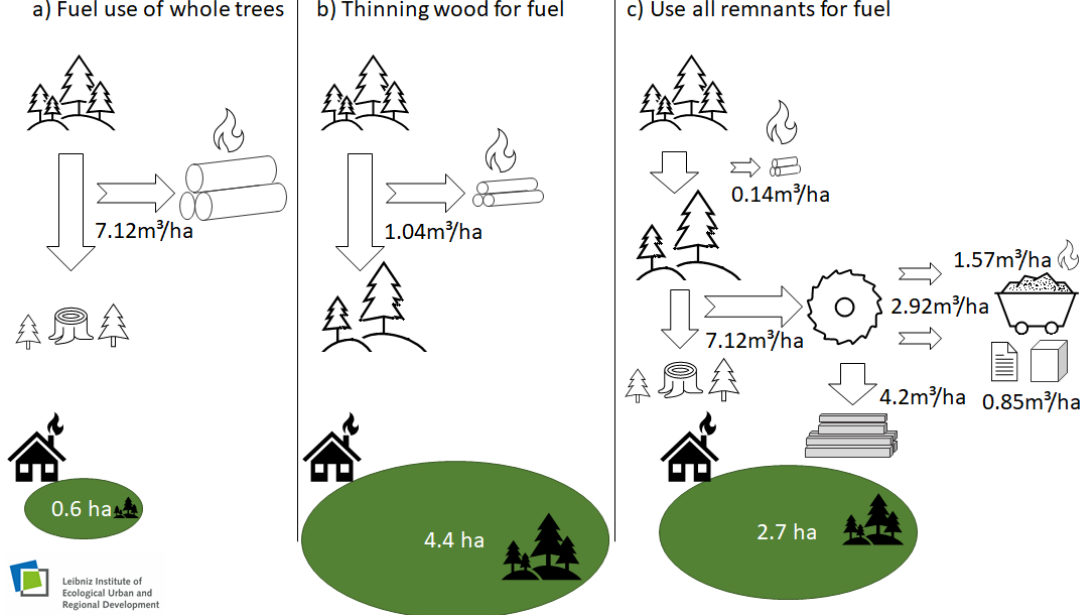
Figure 2. Land demands of wood fuel supply (source: authors) types: ( a ) when using the heartwood of entire trees for fuel, ( b ) when using the thinning wood for fuel, ( c ) when using only forestry and sawmill by-products for fuel and wooden materials proportionally.